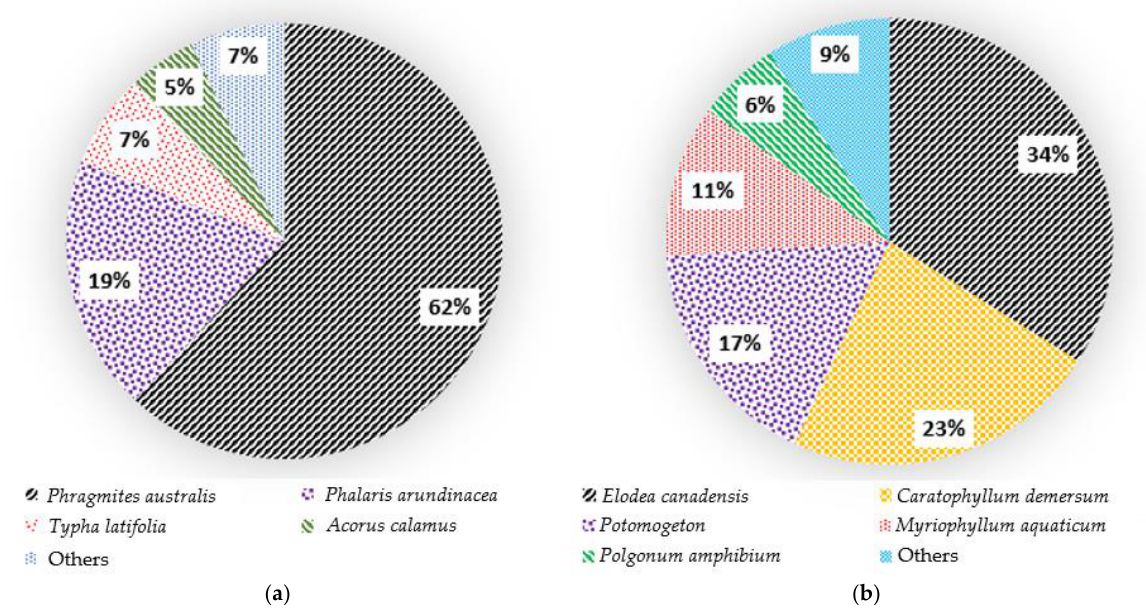
Figure 4. Species composition of hydrophyte biomass harvested during research works (( a ) biomass tested in S1; ( b ) biomass tested in S2).